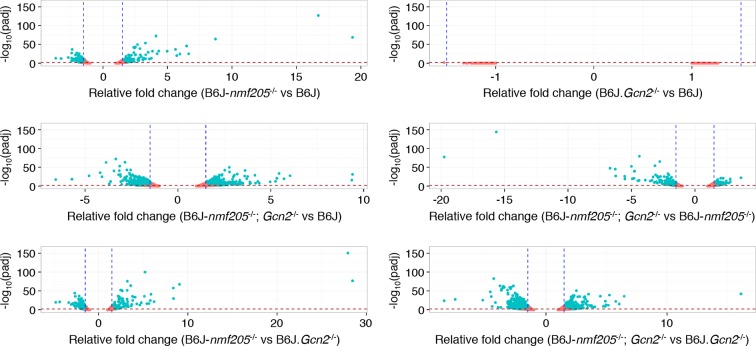
RNA-Seq analysis.Volcano plots of pairwise genotype comparisons of transcripts from RNA-SEQ analysis performed on the cerebellum of 3-week-old B6J, B6J. Gcn2-/-, B6J-Gtpbp2nmf205-/- (B6J-nmf205-/-), and B6J-Gtpbp2nmf205-/- (B6J-nmf205-/-); Gcn2-/- mice. Thresholds of a relative fold change of 1.5 fold (vertical lines) and a p-value of 0.05 (horizontal lines) were adopted for this study.